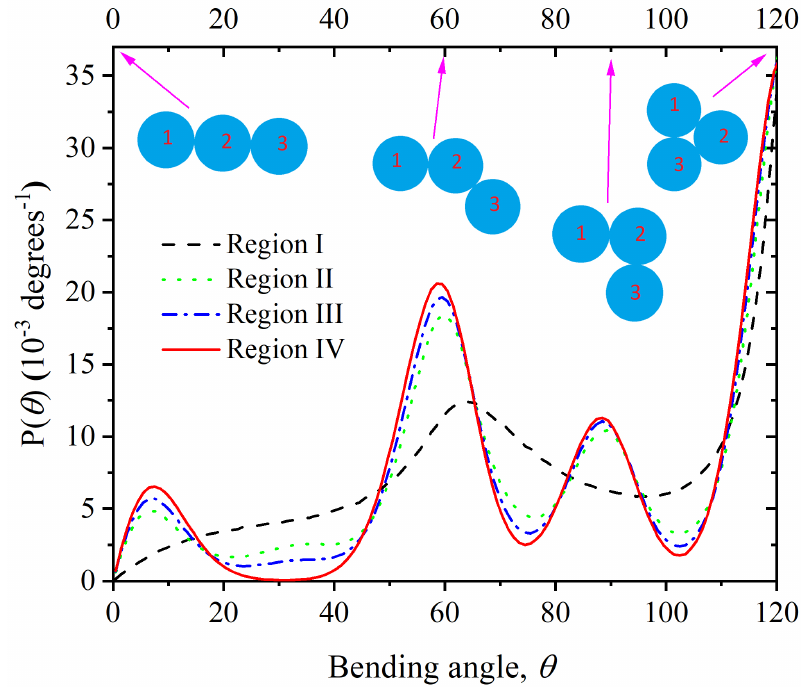
Figure 7. Probability distribution function of bending angles averaged over Regions I through IV. Values of θ > 120 ◦ are forbidden, due to an overlap of monomers 1–3. Three-site arrangements that correspond to specific bending angles are sketched as indicated by the arrows. The following color and style format is used throughout the manuscript: Region I (dashed black); Region II (dotted green); Region III (dashed-dotted blue); Region IV (solid